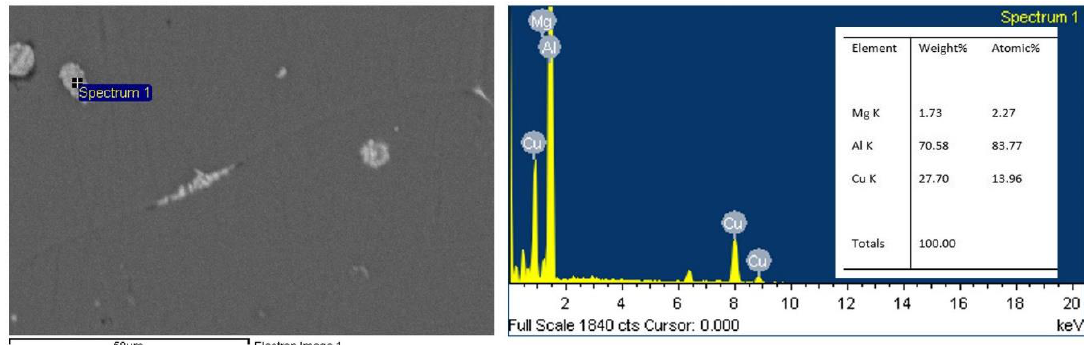
Figure 4. Energy-dispersive X-ray analysis (EDX) analysis of precipitate in L-1.4Mg alloy at peak-aged state.